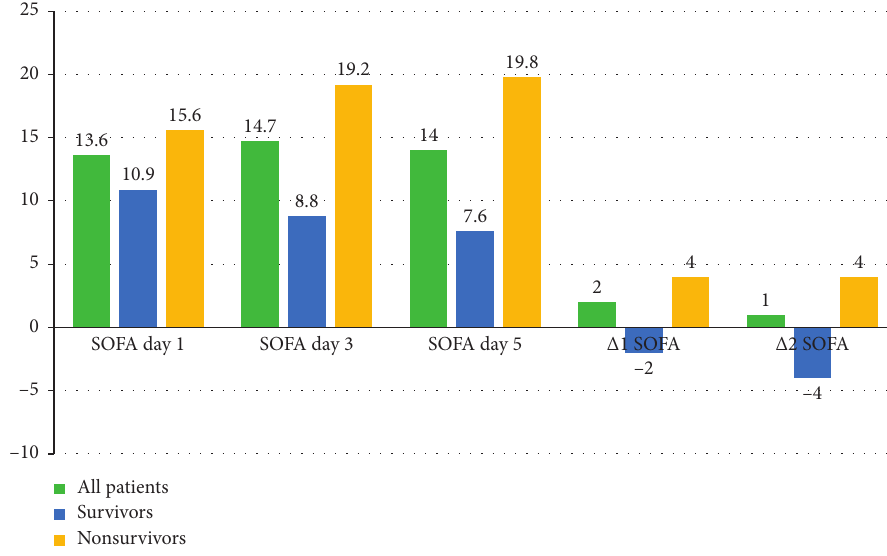
Figure 1: SOFA scoring of studied VA-ECMO patients. Table 6: The validity measures of SOFA scoring of studied VA-ECMO